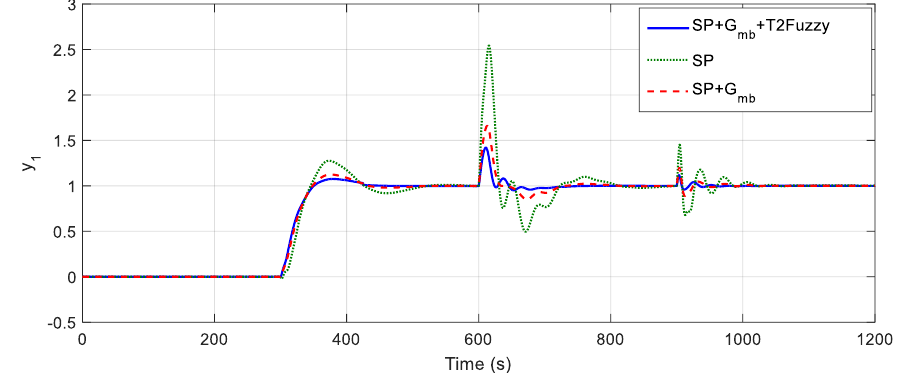
Figure 19. Performance of three control methods for 𝑦 1 for example 2.